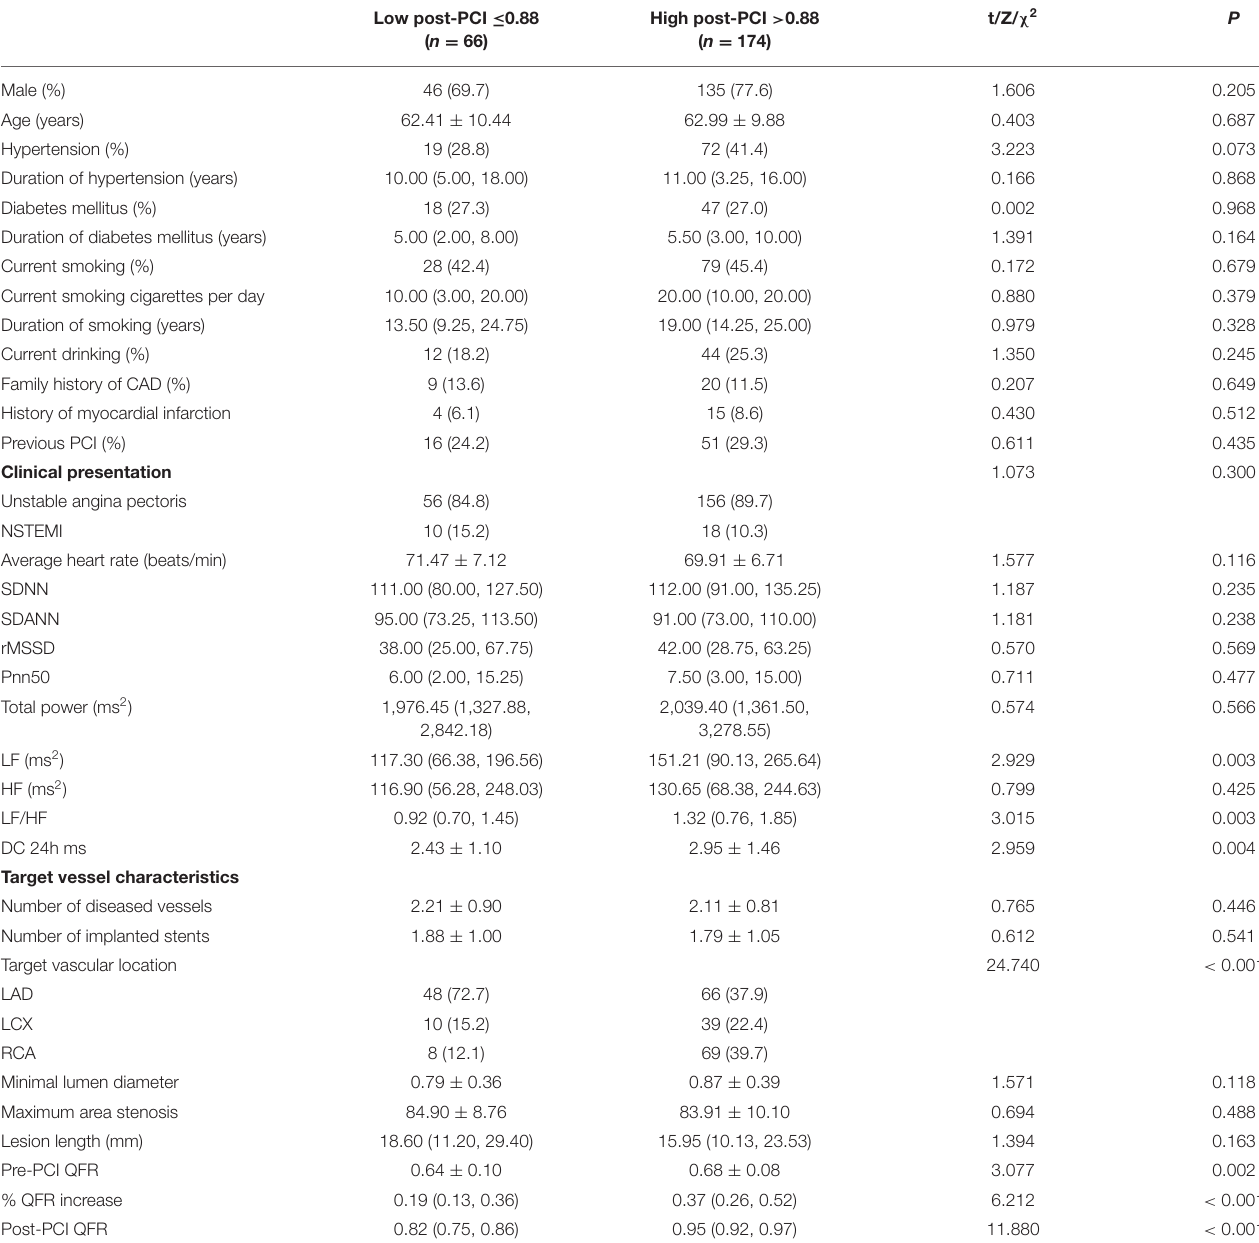
TABLE 3 | Comparison of patient information and characteristics of target vessels in patients with NSTE-ACS according to post-PCI QFR of the target